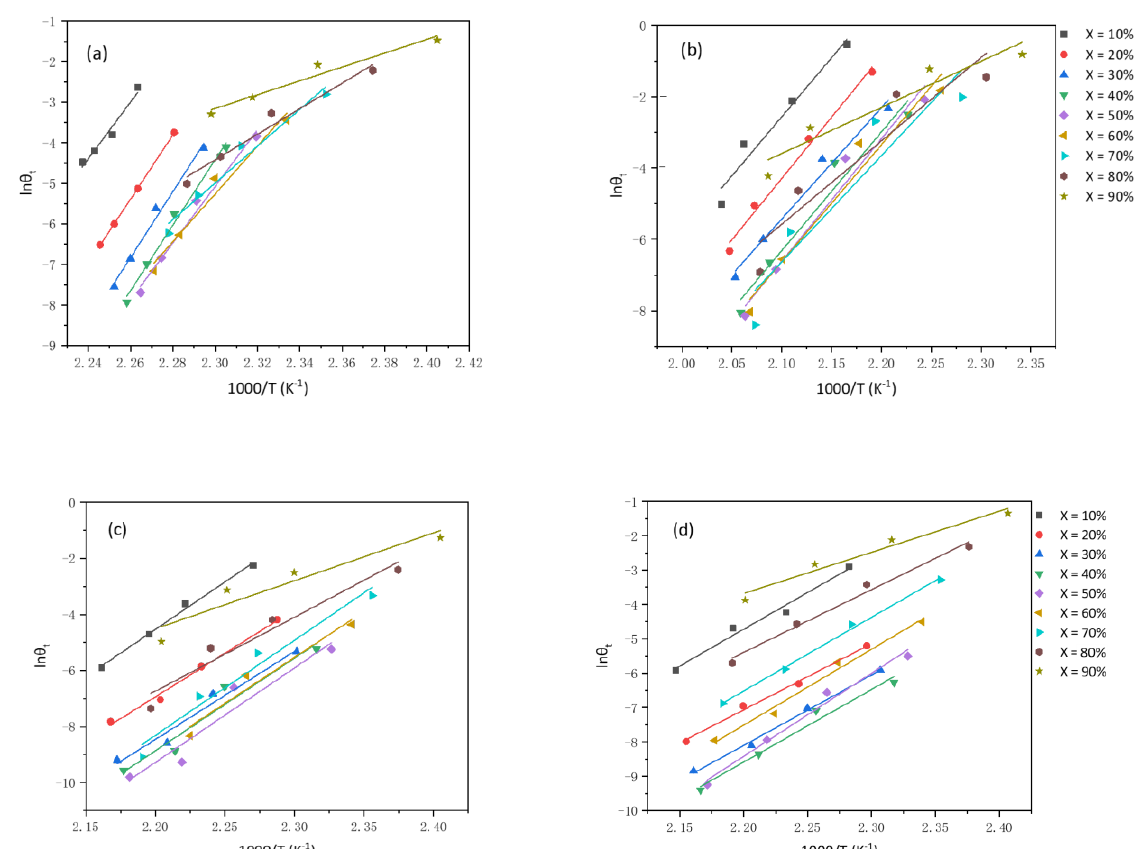
Figure 14. Friedman plots of TPAE-1000 ( a ), TPAE-1500 ( b ), TPAE-2000 ( c ) and PA10T/10I ( d ).